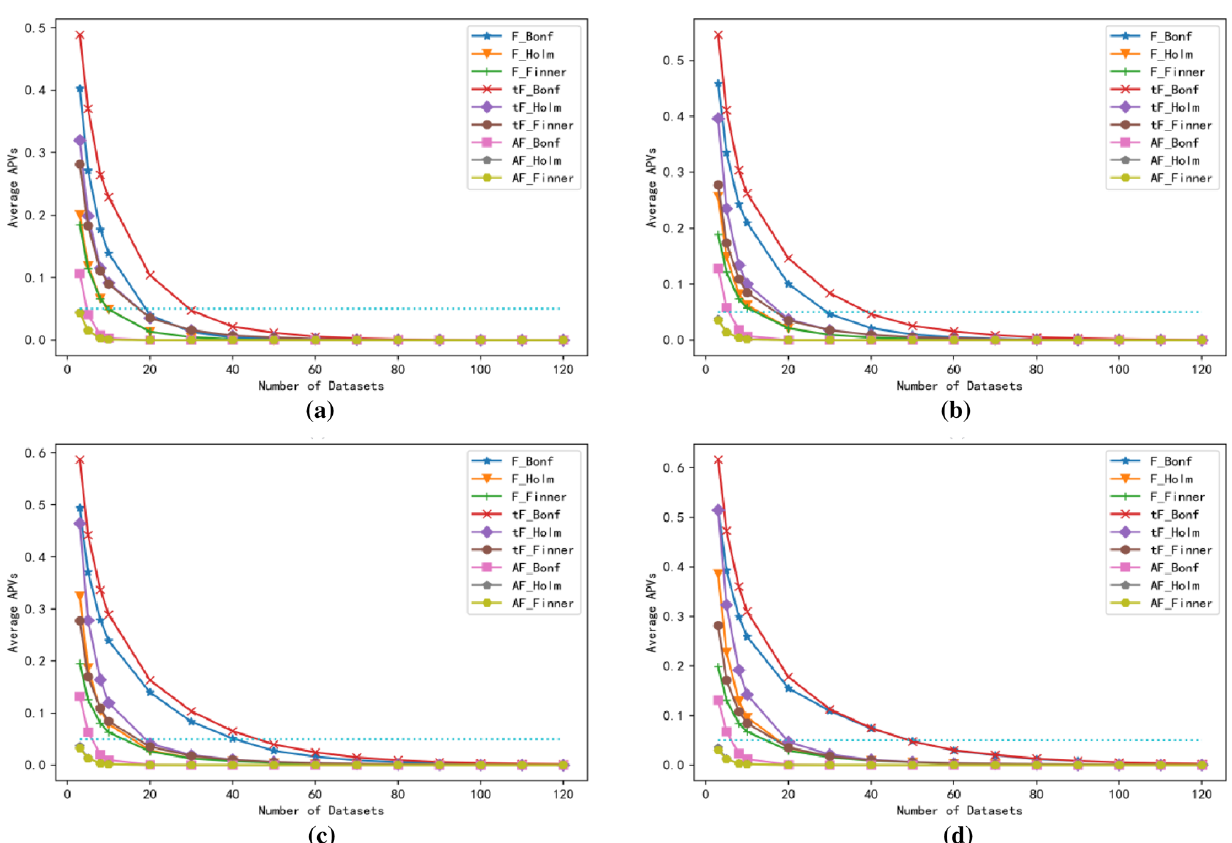
Fig. 12 Average APVs of different nonparametric statistical tests under the experiment setting viii: a the number of algorithms K = 4; b K = 6; c K = 8; d K = 10